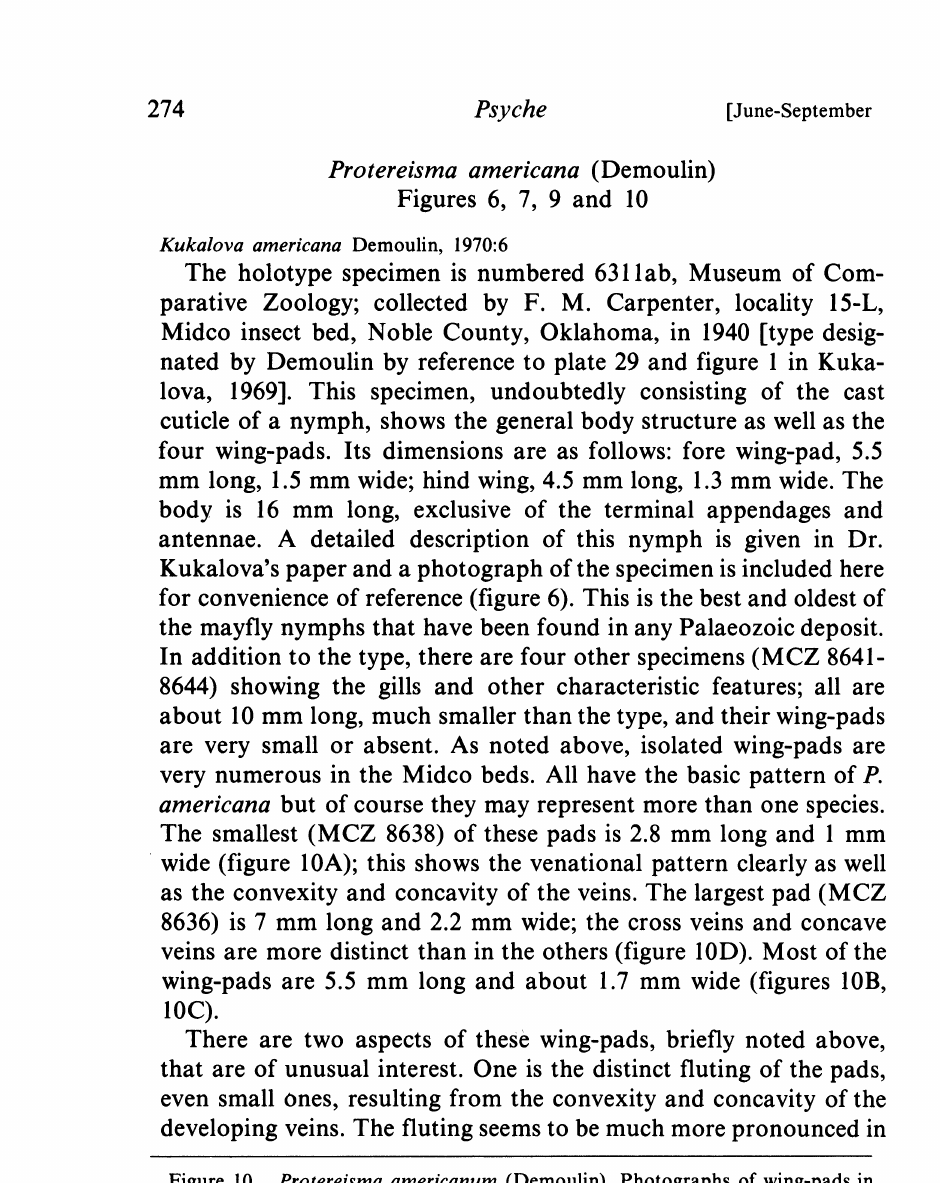
Figure 10. Protereisma americanum (Demoulin). Photographs of wing-pads in several stages of development. A, smallest wing-pad found, 2.8 mm long, mm wide, showing definite convexities and concavities; MCZ 8638, Permian of